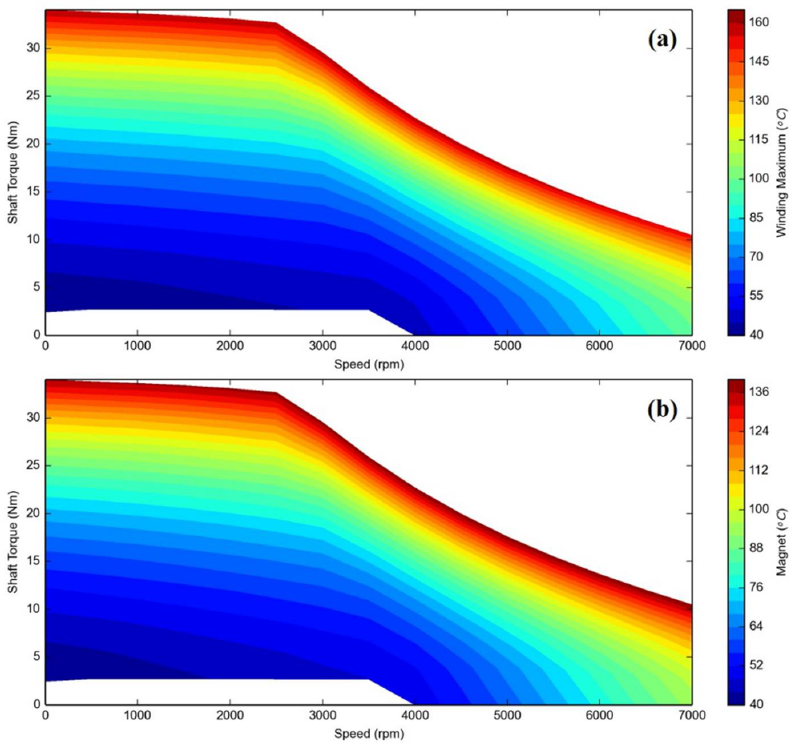
Figure 16. The temperature distribution profiles for ( a ) winding and ( b ) magnet of double-layer IPMSM.